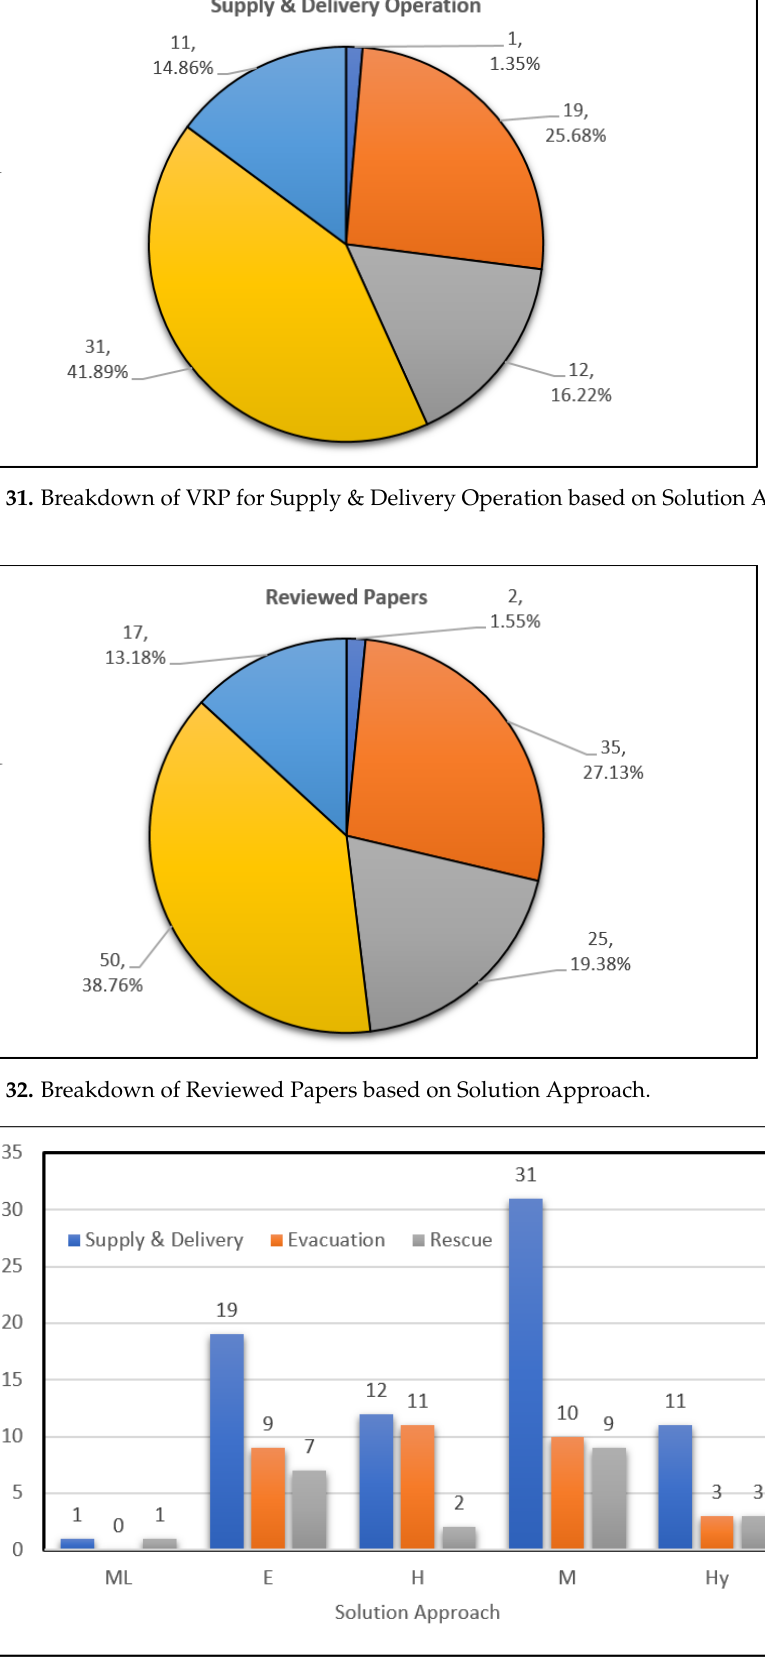
Figure 33. Selected Humanitarian Operation based on Solution